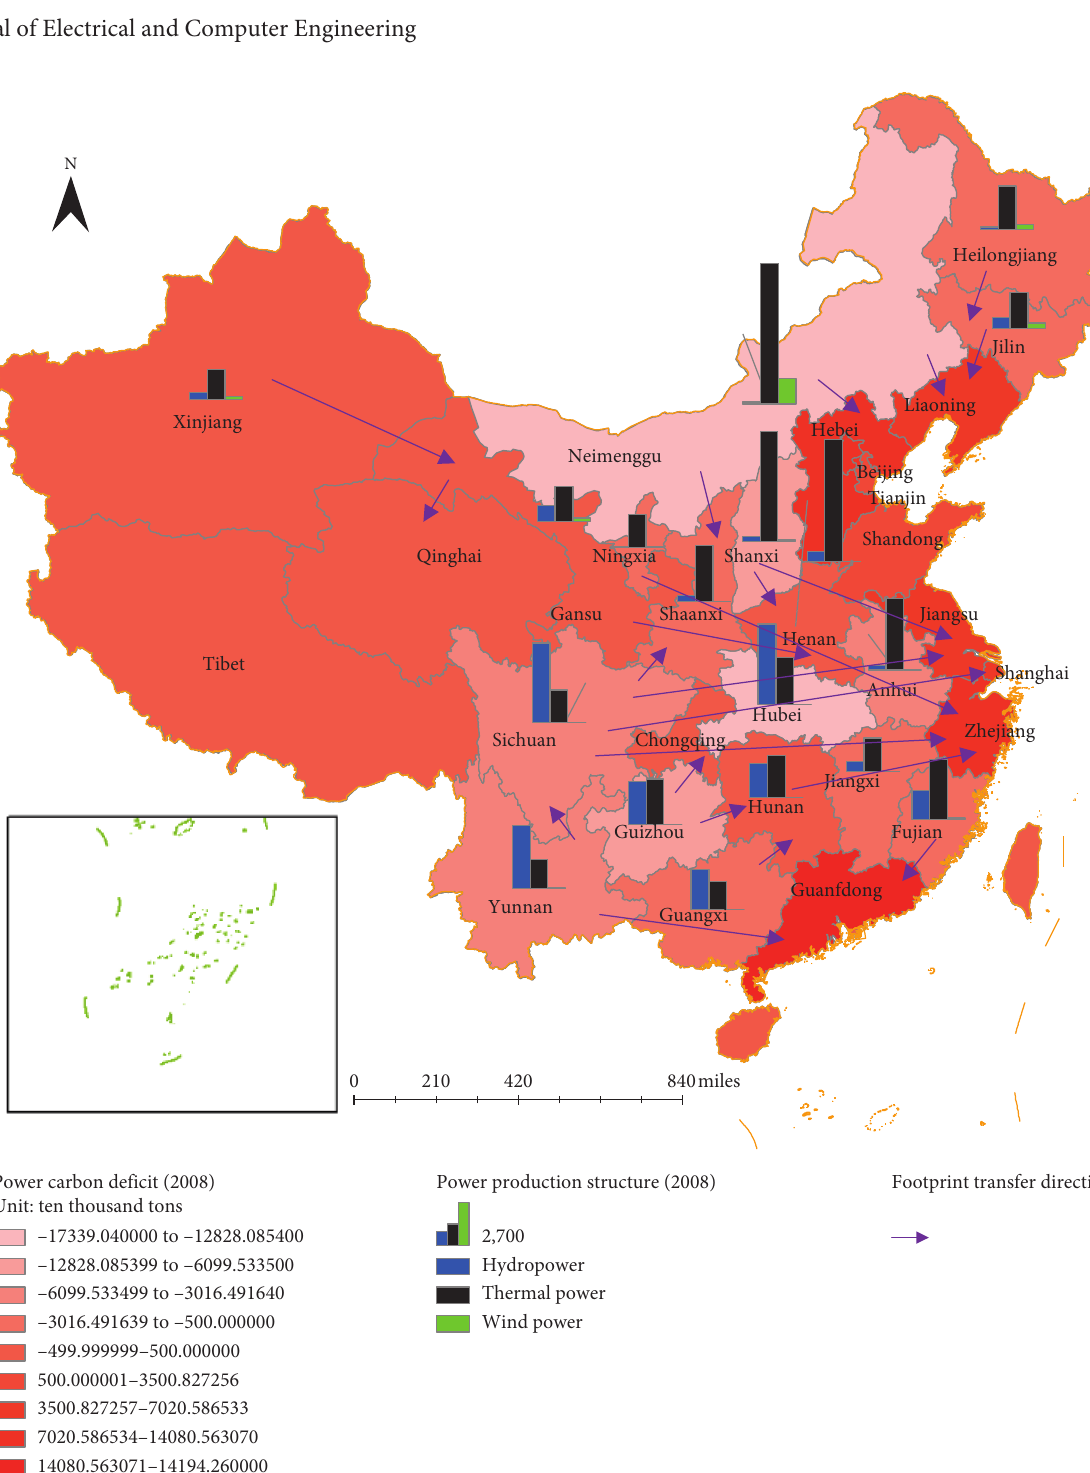
Figure 8: Distribution map of China’s power carbon footprint deficit in